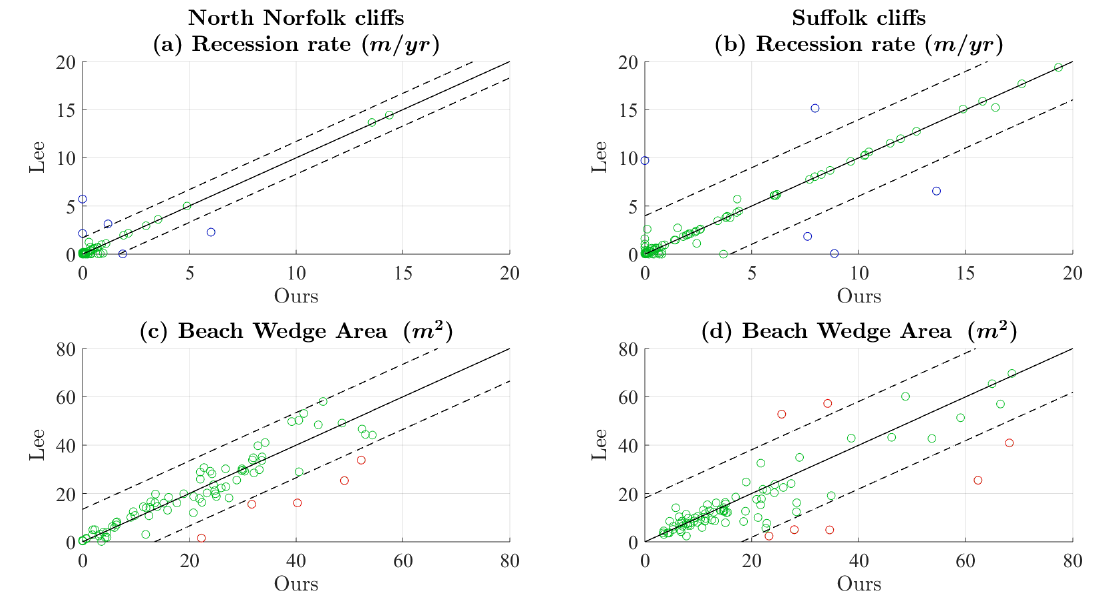
Figure 5. Scatter plot using [3] and our calculated cliff top recession rate and beach wedge area (BWA) for North Norfolk ( a , c ) and ( b , d ) Suffolk cliffs. The blue and red marked points are outliers from recession rate and BWA, respectively. Here, we used a unique MHWS for each location, based on the previous work (see Table